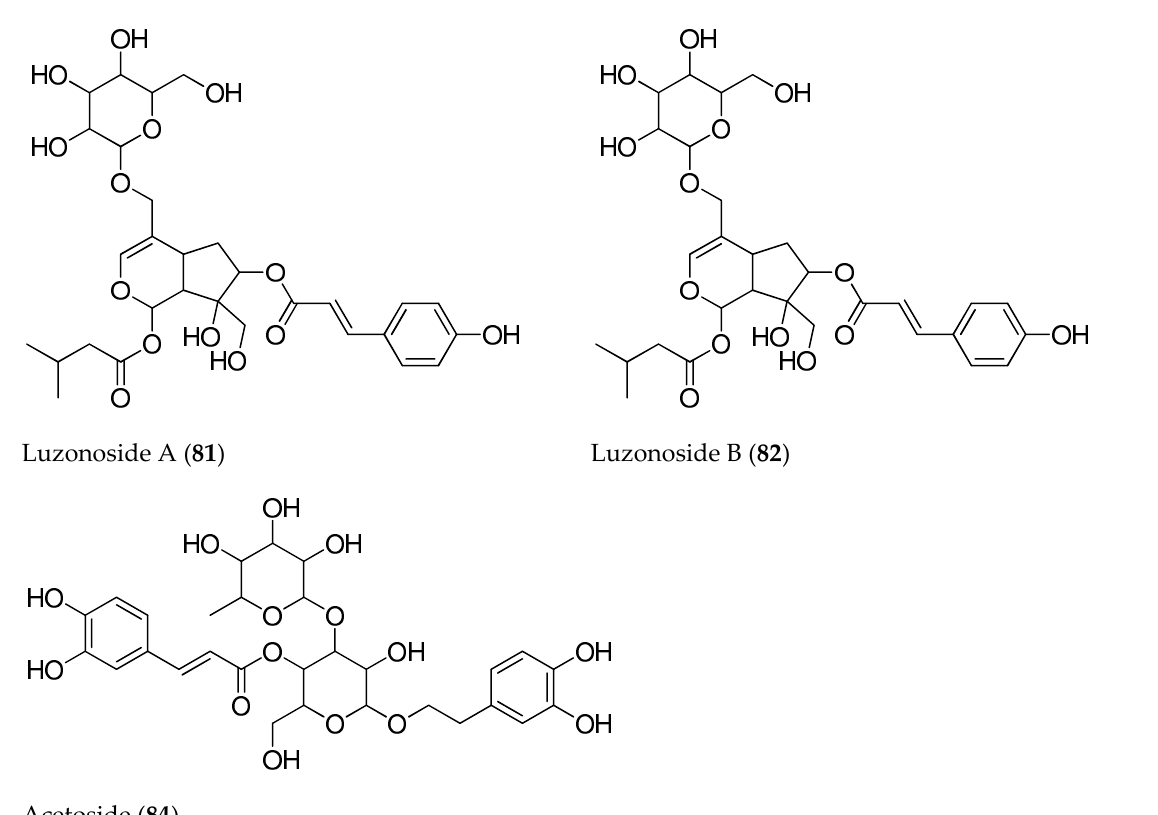
Figure 2. Some of the iridoids reported in isolation and anticancer studies.